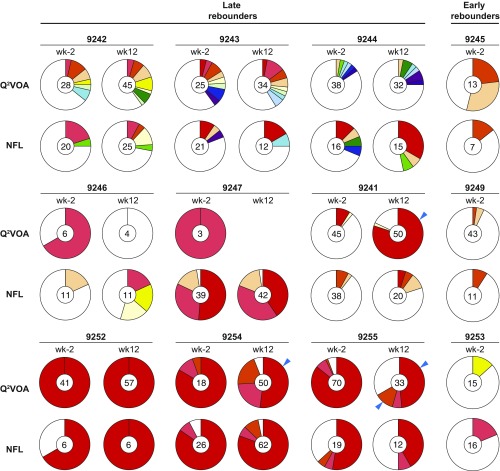
Qualitative analysis of the circulating latent reservoir. Pie charts show the clonal distribution of env sequences derived from Q2VOA (17) or NFL sequencing for each participant at the preinfusion (wk-2) and week 12 (wk12) time points. The number in the middle indicates the total number of env sequences analyzed. White slices represent unique sequences isolated only once across both time points from both Q2VOA and NFL sequencing (singles), and colored slices represent identical sequences that appear more than once (clones). The colors of the slices represent identical sequences found in Q2VOA and in NFL. Blue arrows indicate clones that show significant differences between the time points (17).